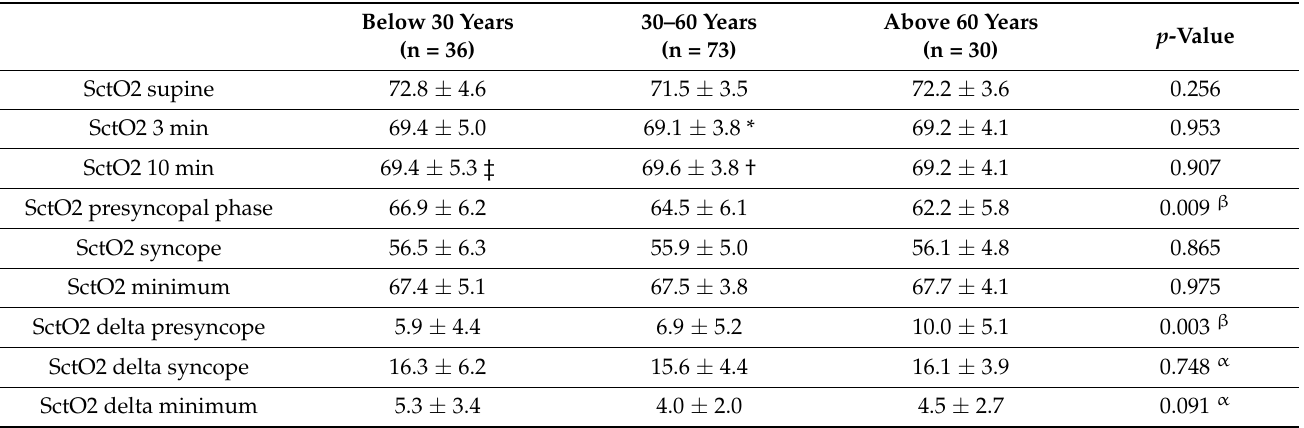
Table 2. Cerebral tissue oxygenation according to age in VVS patients during head-up tilt test.